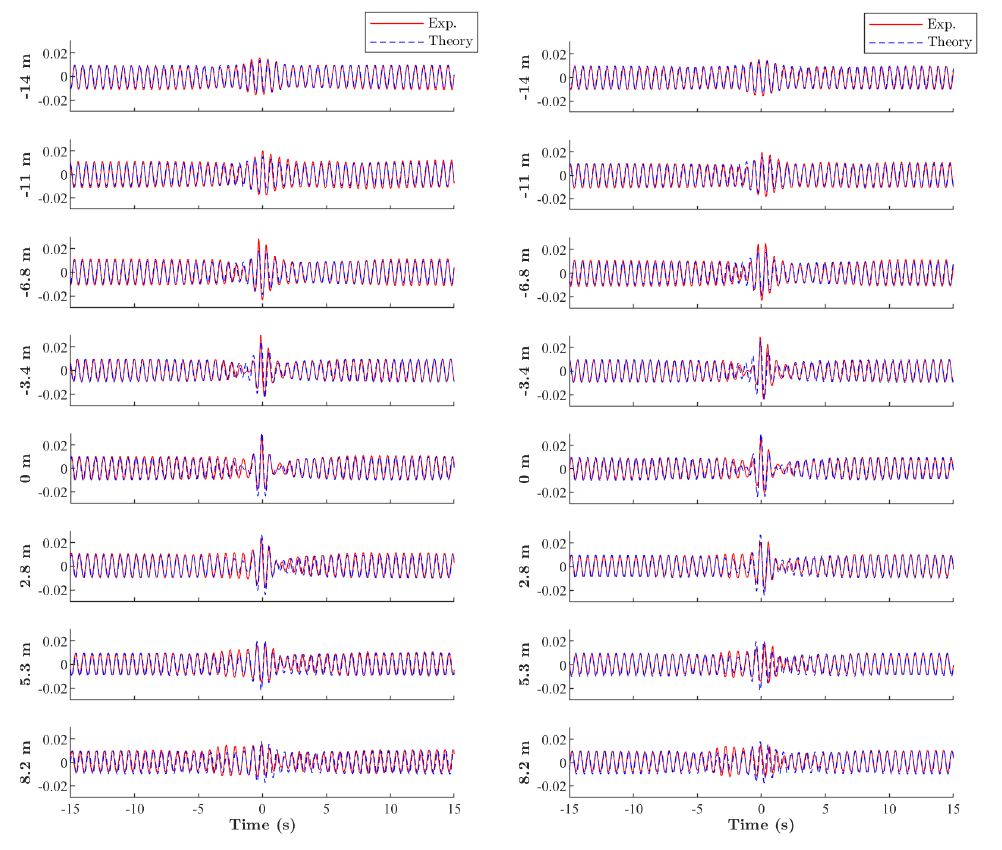
Figure 6. The experimental measurements compared with the corresponding theoretical predictions for the time- ( left ) and space-like ( right ) Peregrine breather